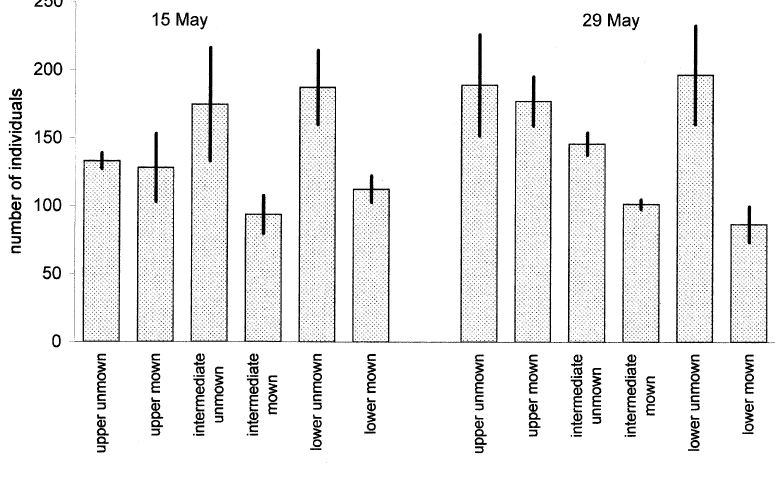
Fig. 7. Average number and stand- ard error of Auchenorrhyncha lar- vae in the different plots in 1998, from suction